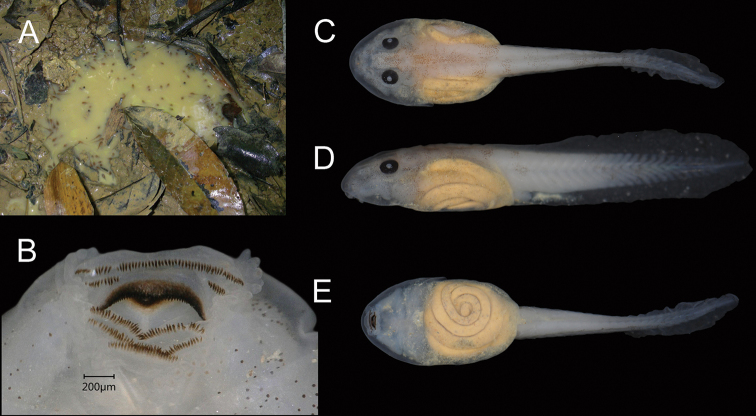
Limnonectessavan sp. nov. larvae Ain situ in puddle in wet gully in semi-evergreen forest in Savannakhet Province, Laos; one exemplar larva in preservative (NCSM 76492) at Gosner Stage 31, TL 18.4 mm in B oral view C dorsal view D lateral view and E ventral view.